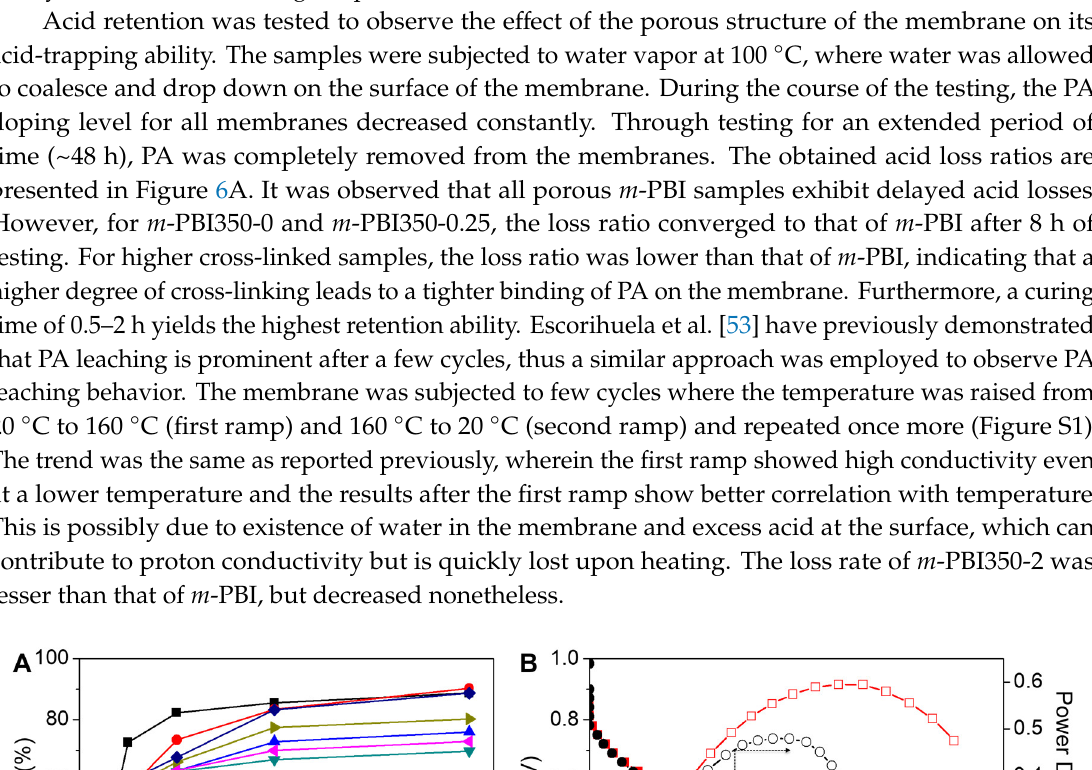
Figure 7. ( A ) Fuel cell performance of m -PBI350-2 with respect to time at a constant current density. ( B ) Cell performances before and after the durability test. As m -PBI350-2 achieved a stable performance, the durability of the membrane was also tested (Figure 7B). The long-term durability loss of m -PBI is attributed to acid leaching [56], which is more extensive for a porous membrane than dense m -PBI because there is an excessive amount of free acid. The cell was placed under a current load of 200 mA cm −2 , and a full polarization curve was obtained every 4 h. Moreover, the voltage was monitored constantly. After a run time of ~250 h, the cell voltage decreased from 0.705 V to 0.686 V when operated under 200 mA cm −2 (loss rate: 77.5 μV h −1 ). Although porous membranes feature lower durability than dense m -PBI [55], the leaching of free acid was minimized, similar to the acid retention ability. 4. Conclusions